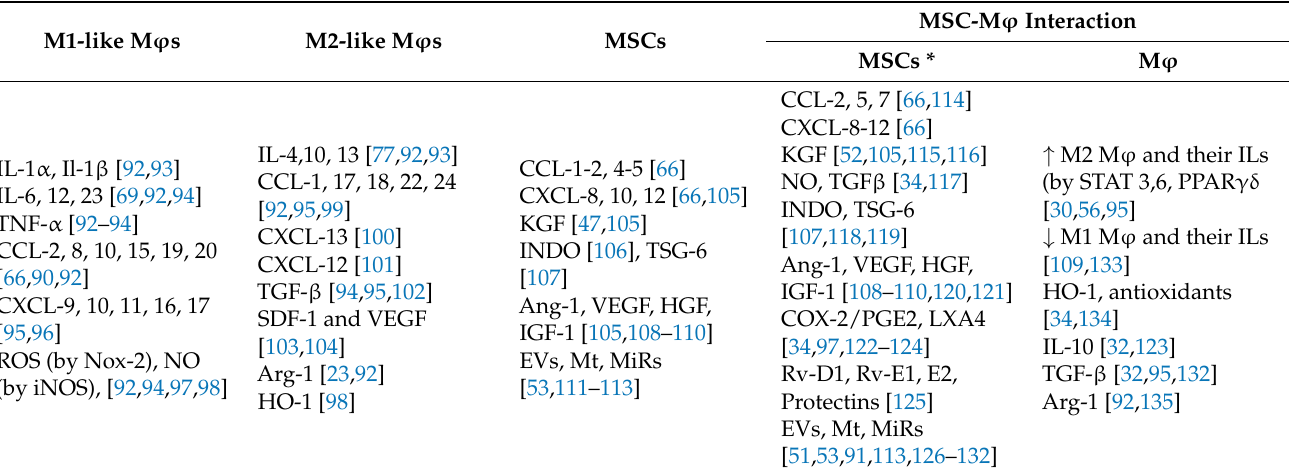
Table 2. Key factors secreted by M1-like and M2-like M ϕ s and MSCs alone and the effects of MSC-M ϕ interaction on secreted